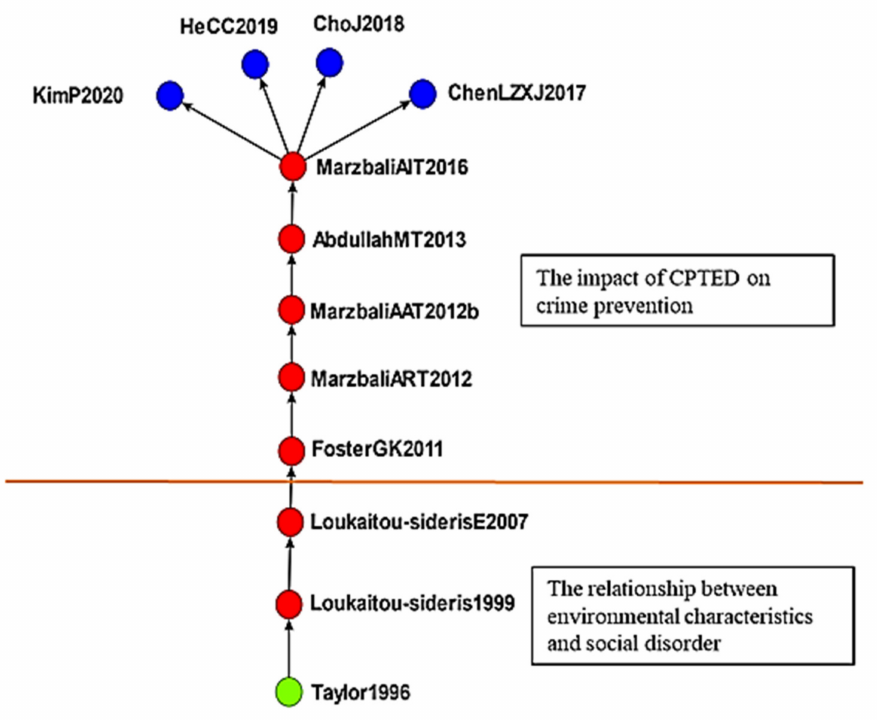
Figure 7. Global main path analysis of second cluster. (Top to bottom). The effects of CPTED; relationship between environmental characteristics and social disorder.